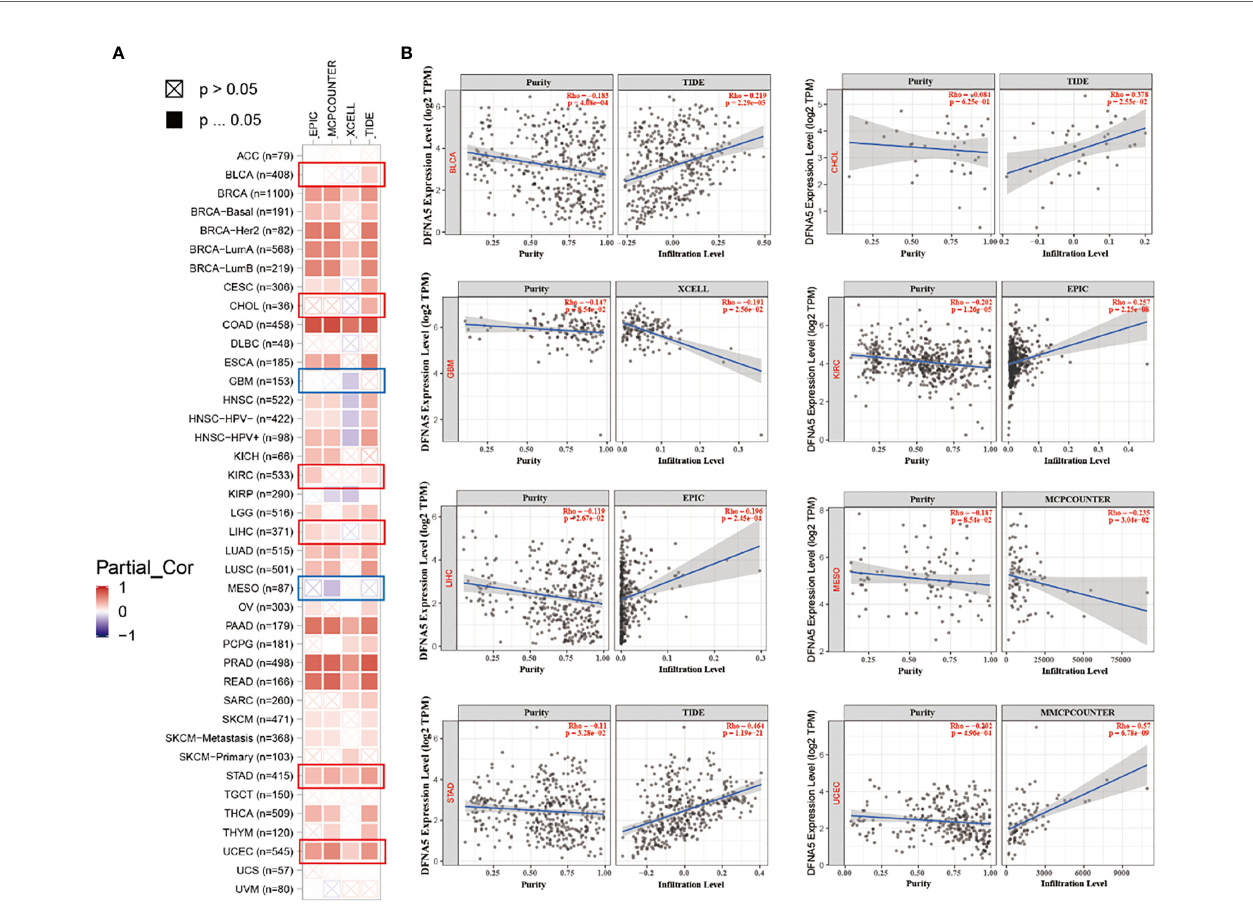
FIGURE 4 | (A) The potential correlation between GSDME expression and immune cell in fi ltration of cancer-associated fi broblasts in all TCGA cancers. (B) The scatter plots of related cancers generated by one algorithm, including BLCA, CHOL, GBM, KIRC, LIHC, MESO, STAD and